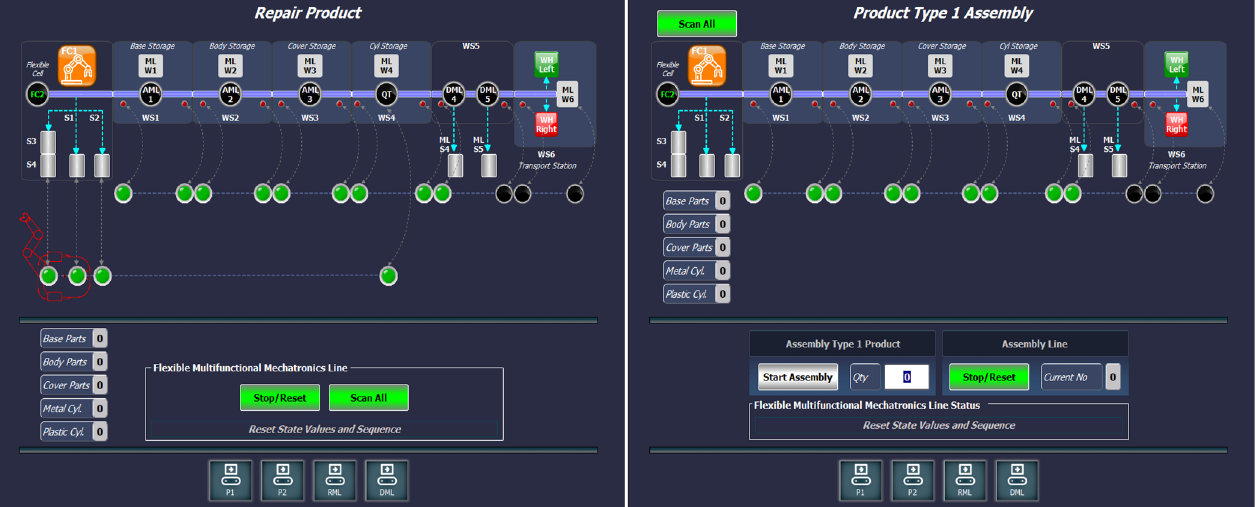
Figure 20. SCADA with Siemens TIA implementation for A/D/RML.